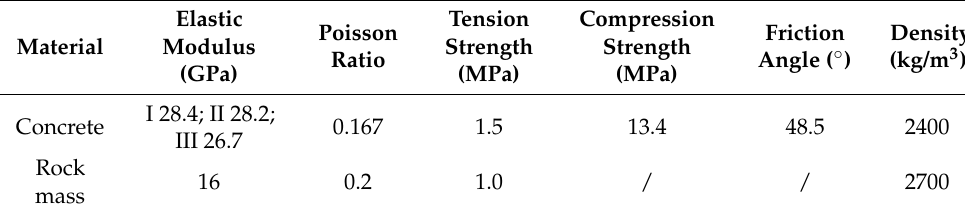
Table 1. Material parameters of the RCC dam.